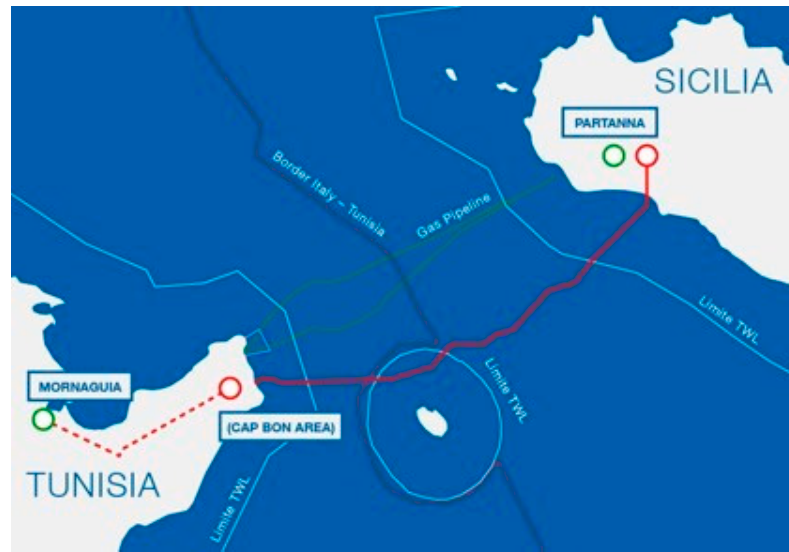
Figure 3. The ELMED project is the new interconnection between Partanna, Sicily (IT), and Menzel Figure 3. The ELMED. Temime, Tunisia (TU). [Source: TERNA SpA